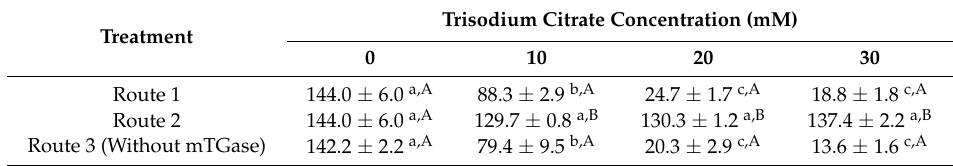
Table 1. The effects of trisodium citrate on the average diameter (nm) of casein particles 1 .